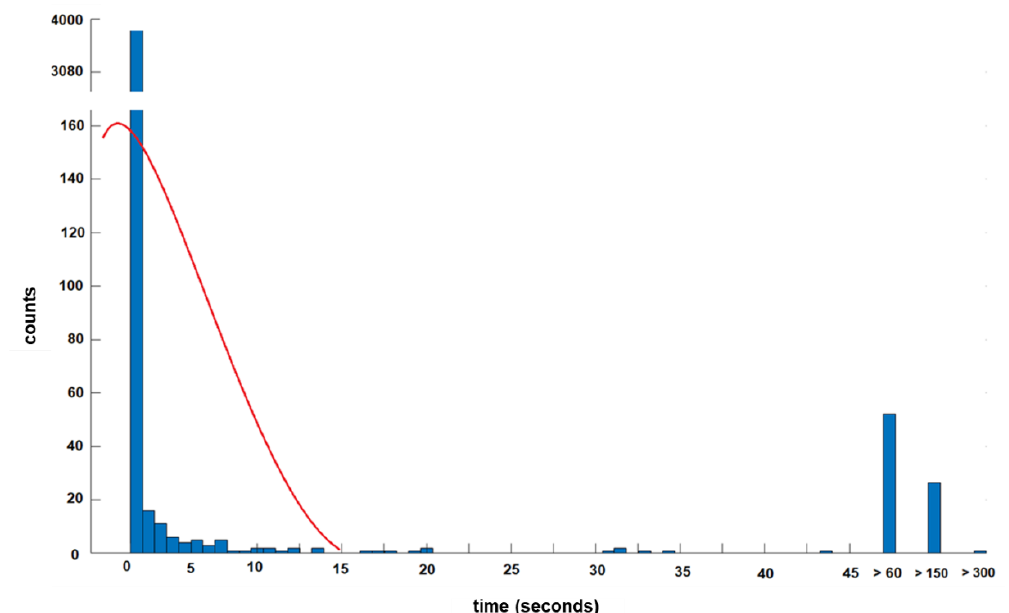
Figure 5. Distribution of time intervals between Signal Magnitude Area to define the 15 s threshold . In this 5 h pilot recording, left plots (<15 s) reflect rapid activity fluctuations and no position changes. Thus, the authors defined the cutoff at 15 s to detect position changes. Activity blocks shorter than15 s were merged with neighbor blocks using the most similar tilt angle and then, data were re-averaged to create smooth blocks. Threshold was at 0.2 g to distinguish rest and activity.